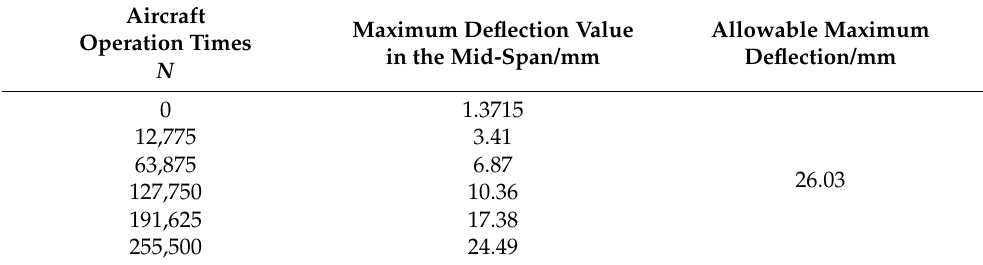
Table 5. The relationship between the taxiway bridge deflection and aircraft operation